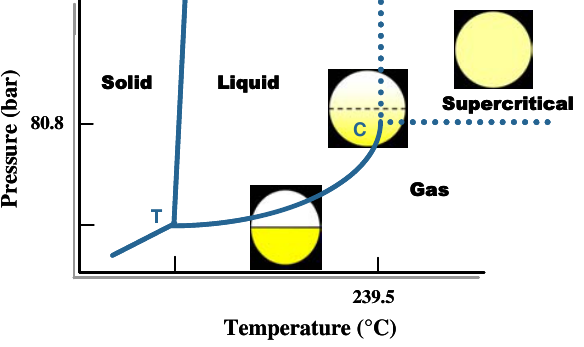
Fig 7. The phase diagram of methanol. The critical point ( T c = 239.5 °C, p c = 80.8 bar) is indicated as